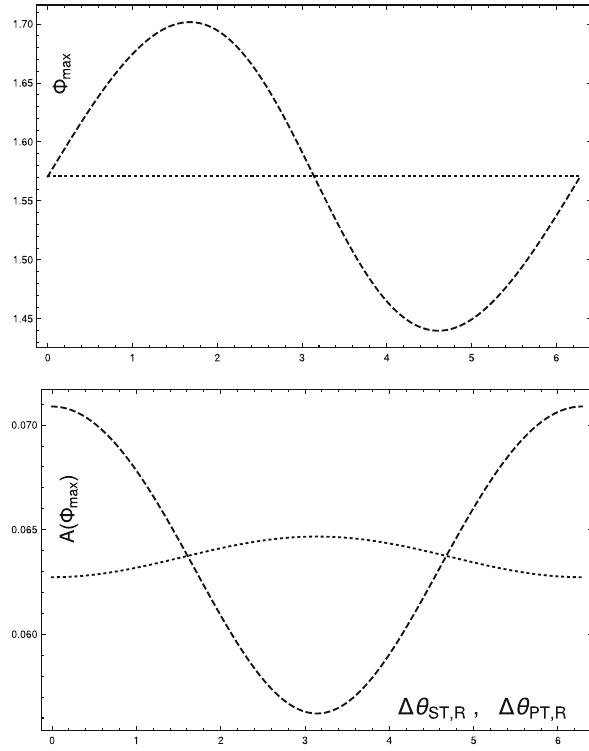
| = | c R | = 0 . 2 S T | = | c R | = 0 . 2 (dotted line). P T